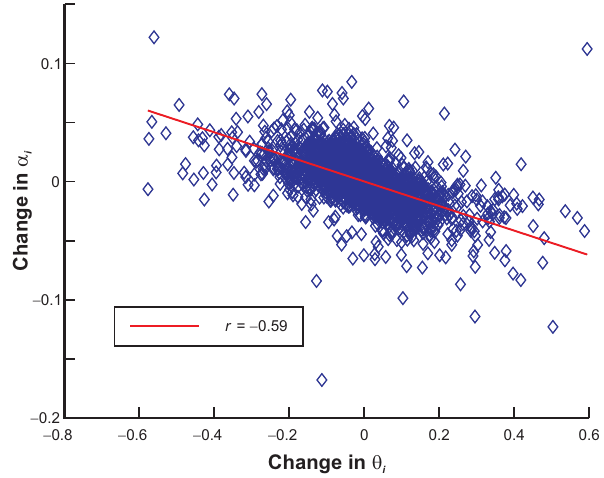
Fig. 3. Change in θ i versus change in α i between subsequent AWS recording time steps (10min) for the melt season 2007/08. The linear fit has slope